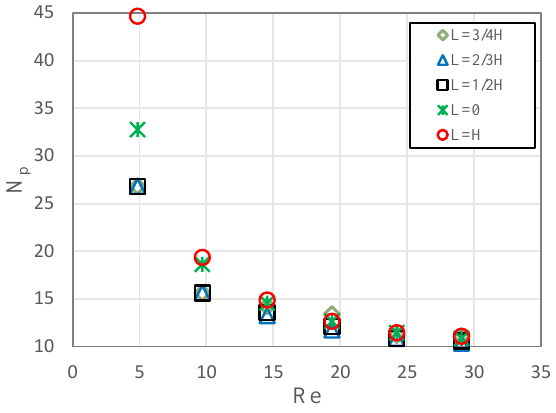
Fig. 2. Power number N p for Rushton turbine and fixed impeller distances from the tank bottom h=1/3H and various baffles lengths or no baffles (L=0).